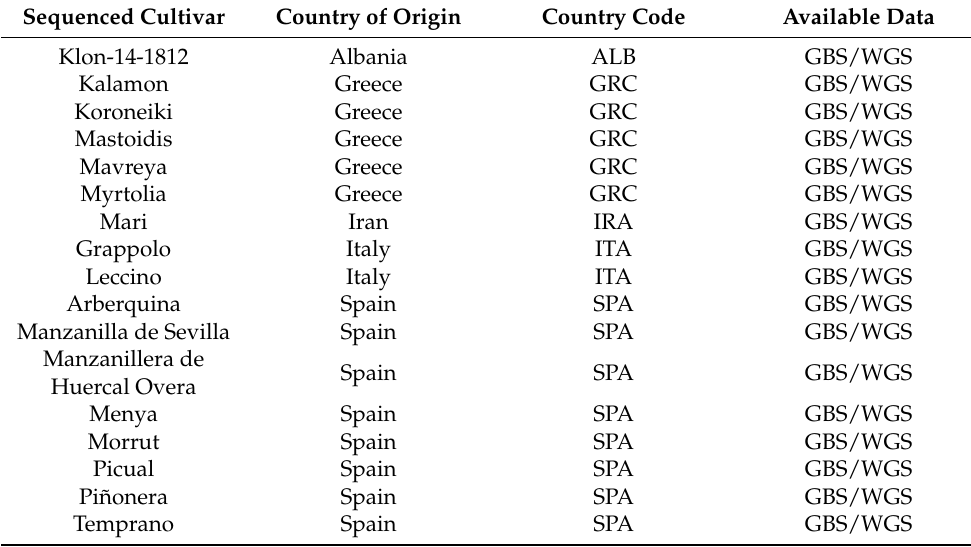
Table 1. List of Olea europaea cultivars sequenced using GBS and available WGS data. Sequenced